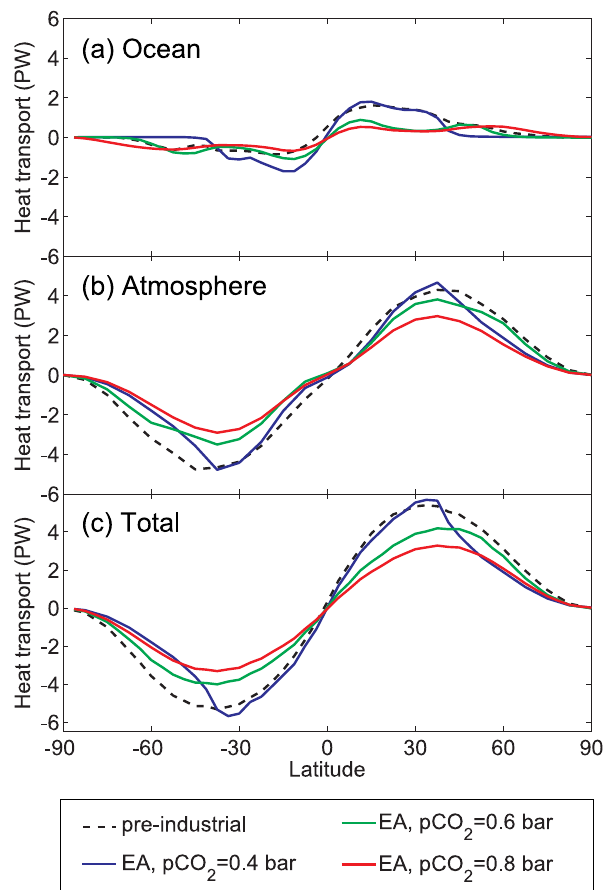
Fig. 16. (a) Oceanic, (b) atmospheric and (c) total meridional heat transport for pre-industrial conditions as well as for the three states of the early Archean